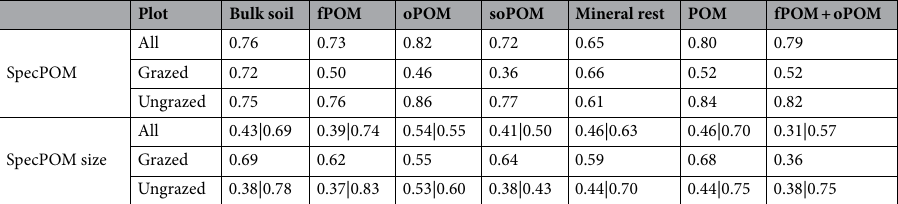
Table 2. Correlation matrix between the spectroscopically identified particulate organic matter (SpecPOM) and the contribution of physically extracted fractions of soil organic matter for each of the 40 blocks (2 plots × 2 profiles per plot × 2 blocks per depth × 5 sampling depths). POM is the sum of the three fractions fPOM, oPOM and soPOM. Pearson’s coefficients of correlation are given for all 40 blocks combined, (“All”) and for the grazed and the ungrazed soil profiles individually. We show the coefficients for the area covered by SpecPOM and the mean size of the SpecPOM particles. The correlations for SpecPOM size and both treatments combined (“All”) are given for all 40 data points (first value) and with two outliers in the first layer of the ungrazed profile excluded (second value; size of 376.96 and 530.85 pixels).